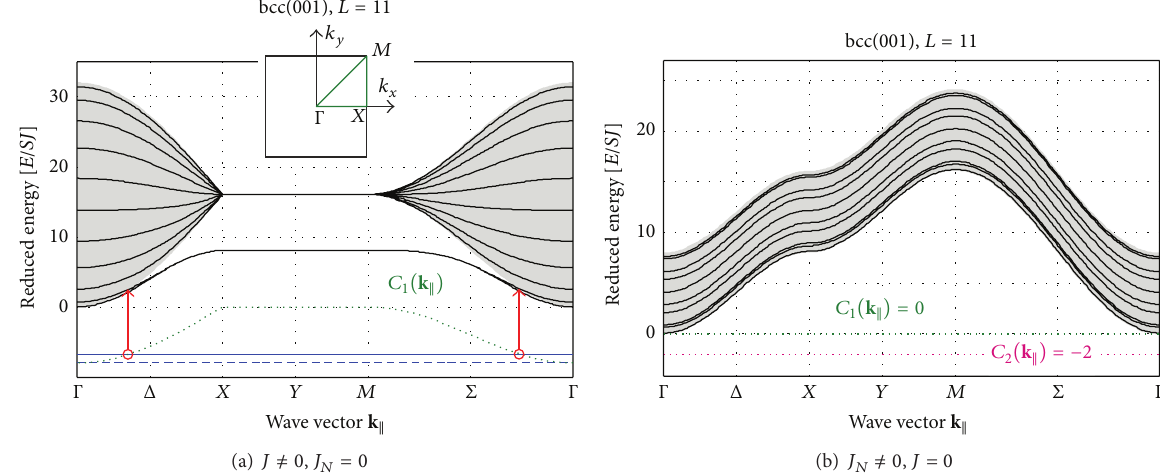
Figure 3: (a) Spin-wave spectrum of an 11-layer thick bcc(001) thin film with no NNN exchange interactions. Solid lines represent the energy of individual modes; the shaded area is the bulk band for in-plane spin waves. The spectrum is plotted along the high-symmetry path shown in an inset. The evolution of the off-diagonal Hamiltonian matrix element 𝐶 1 is shown as a green dotted line. Blue lines represent conditions for the surface localization of symmetric (solid line) and antisymmetric (dashed line) modes. Wave vectors for which the antisymmetric mode starts to localize are marked with red arrows. (b) The same as in (a) but for the hypothetical situation in which NN interactions are switched off while NNN interactions are switched on. The purple dotted line represents the evolution of the off-diagonal Hamiltonian matrix element 𝐶 2 .